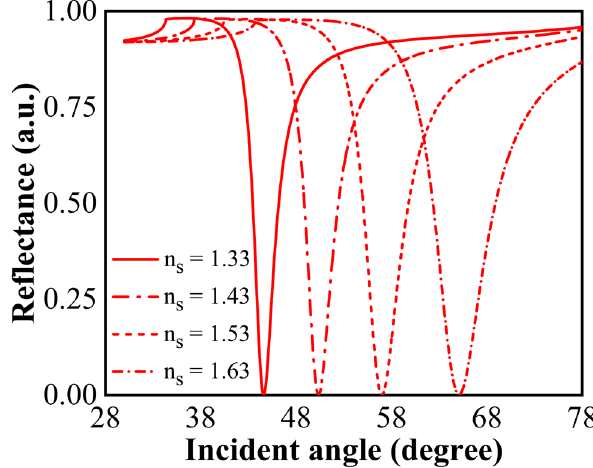
Figure 3: Reflectance curves change with incident angles for differentsensingtargets(differentrefractiveindices[RIs])wherethe thickness of silicon (Si) films is 14 nm, and the number of the black phosphorus(BP)andgraphenelayersis L =1and S